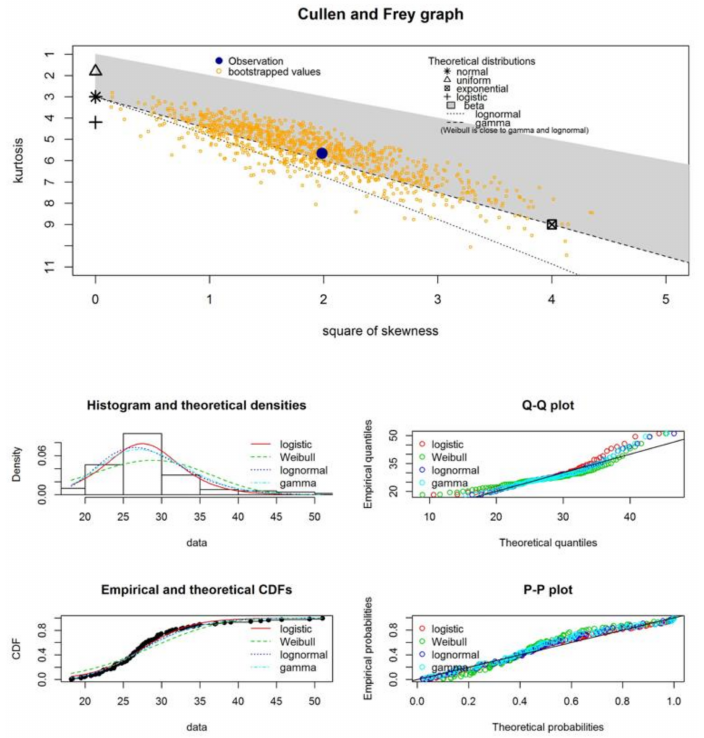
Figure A2. Statistical evaluation of nonwoven samples modified with graphene: ( Top ) Cullen and Frey graph, and ( Bottom ) Probability density plot, cumulative distribution function, Q–Q plot, and P–P